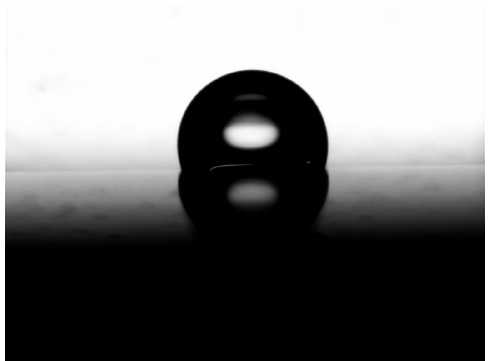
Figure 7. Wetting behavior of a 5 μ L water droplet on a flat PDMS surface with static wetting contact angle about 107.2°.